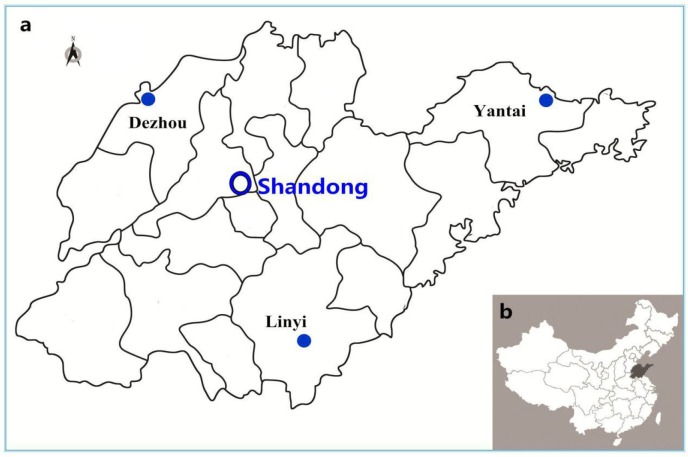
Sampling sites in this study. (A): The enlarged map of Shandong province, in which sampling sites in three administrative districts was marked. (B): The location of Shandong province was highlighted in China.